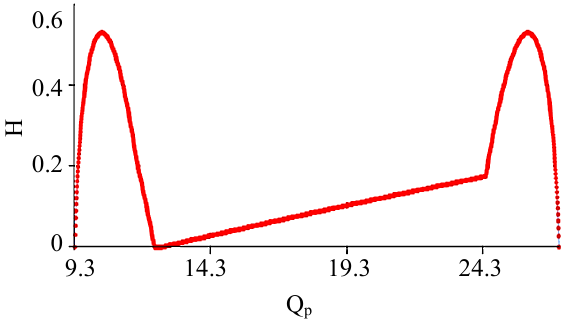
Fig. 5. Graph of fuzzy energy entropy of the system